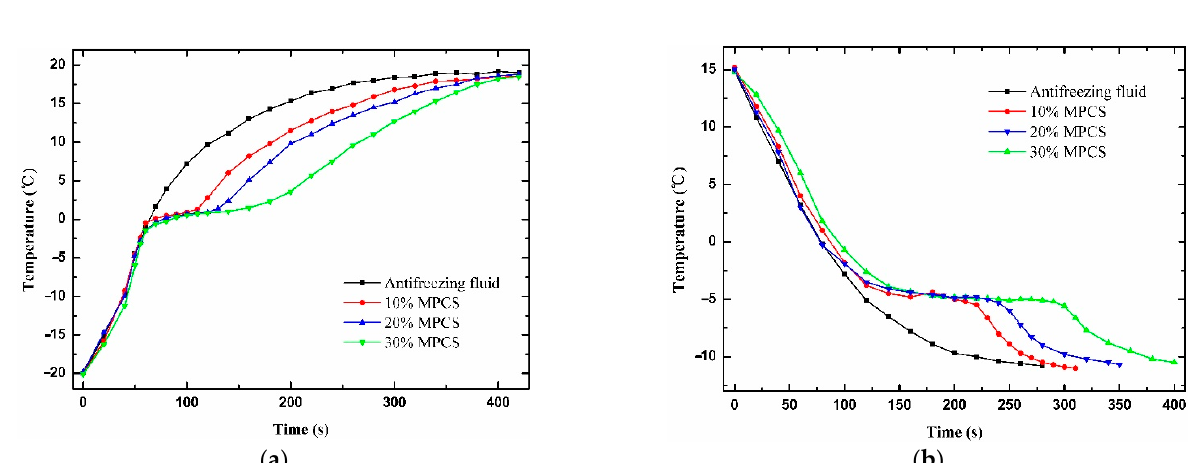
11 of 17 Figure 11. Infrared camera images of petri dishes with antifreeze fluid and different mass concentrations of MPCS under heating process: ( a ) antifreeze fluid ( b ) 10 wt % ( c ) 20 wt % ( d ) 30 wt %. From the heating and cooling characteristic curves of commercial antifreeze fluid and MPCS at different mass concentrations in Figure 12, it is observed that the developing trends of the four curves are different when the temperature reaches the onset melting